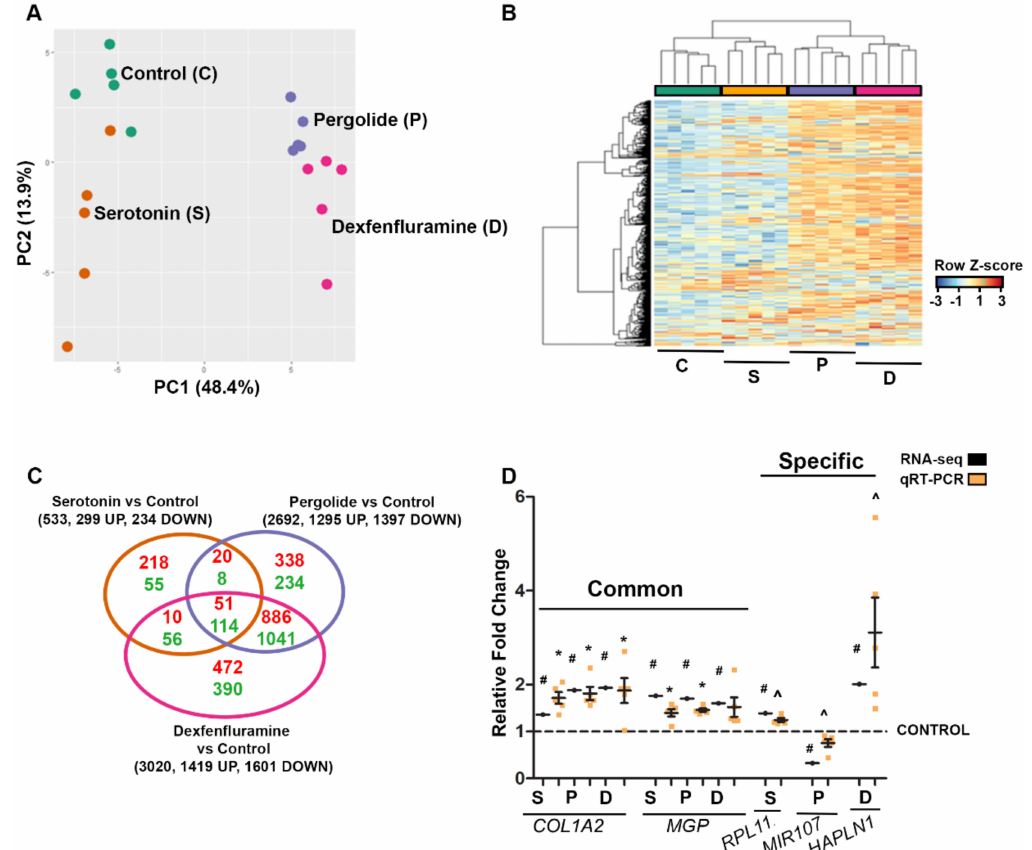
Figure 2. RNA-seq analysis of tricuspid valve (TV) transcriptomes indicate that Pergolide and Dexfenfluramine treatment shares the majority of di ff erentially expressed genes (DEGs). ( A ): Principal component analysis (PCA) on tricuspid valve leaflets treated with water (green dots, n = 5), serotonin (orange dots, n = 5), pergolide (purple dots, n = 5), and dexfenfluramine (pink dots, n = 5). ( B ): Heatmap view of z-scored expression profile of DEGs in TV of rabbits treated with serotonin (n = 5), pergolide (n = 5), and dexfenfluramine (n = 5) compared to control (n = 5). ( C ): Venn diagram displays comparison between DEGs for each drug treatment. ( D ): Data of qRT-PCR (n = 5 per treatment) are reported as dot plots where each dot represents a rabbit and the horizontal bar indicates the mean ± SEM as compared to relative fold change obtained by RNA-seq analysis. # FDR < 0.05, * p < 0.05 determined with one-way ANOVA followed by Dunnett’s multiple comparison test (n = 5 for each treatment). ˆ < 0.05 determined with Mann–Whitney